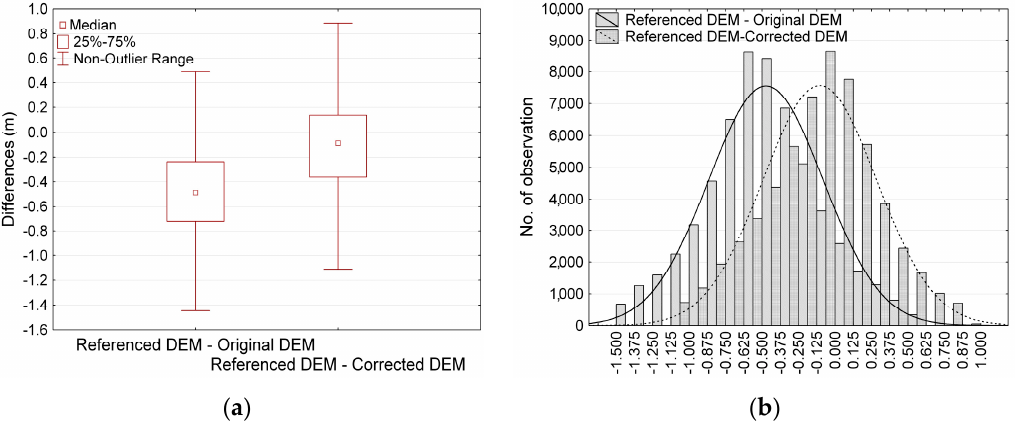
Figure 6. ( a ) Differences between the reference DEM based on LIDAR data and the original DEM and corrected DEM; ( b ) distribution of differences between the models.